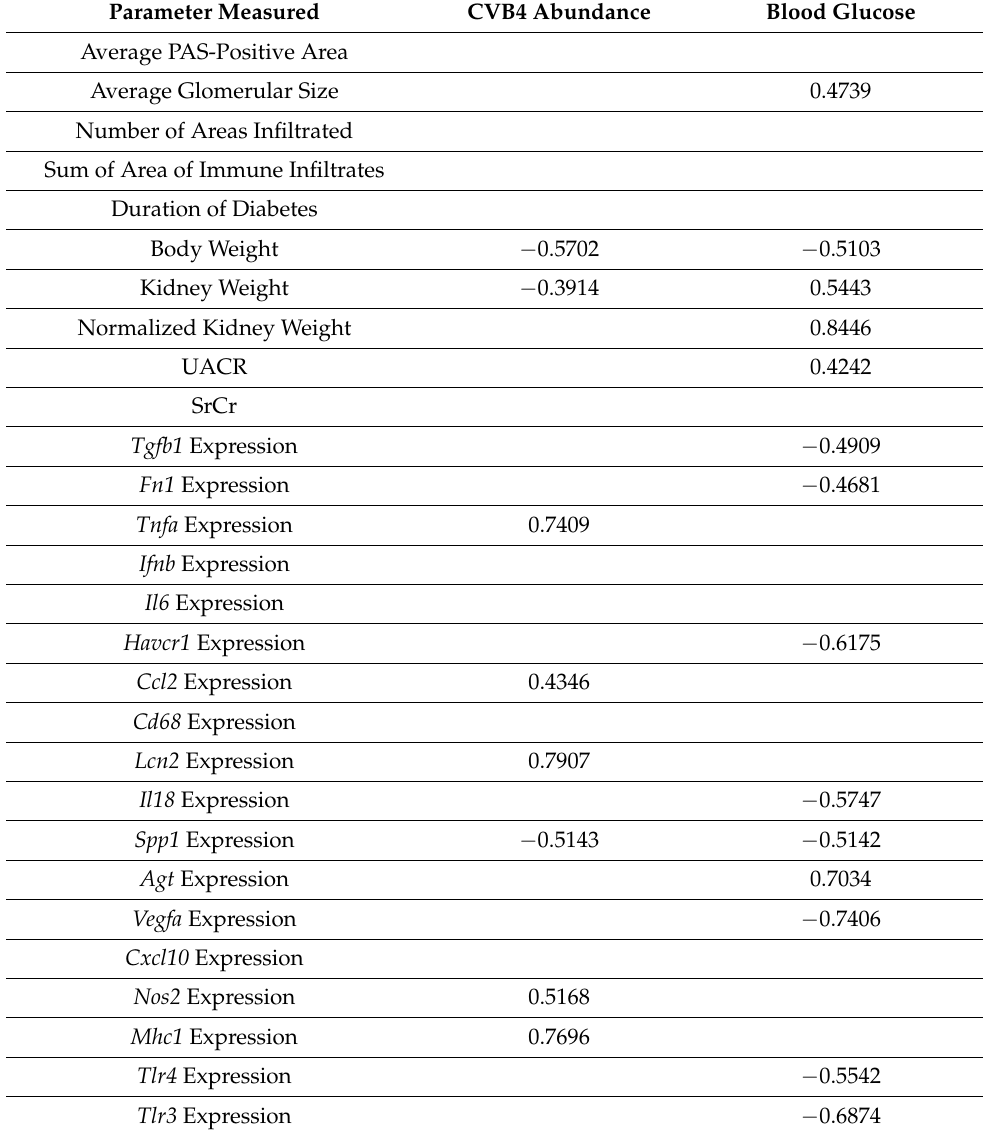
Table 1. Significant Pearson’s correlation coefficients between various measured parameters and CVB4 abundance and blood glucose levels ( p <